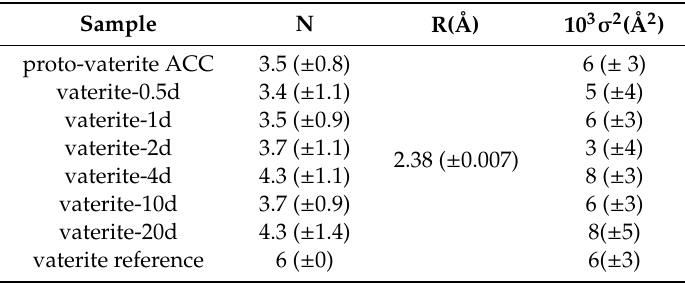
Table 1. The first coordination shell (Ca-O 1 ) fitting results of proto-vaterite ACC, vaterite samples crystallized for di ff erent times and well-crystalline vaterite